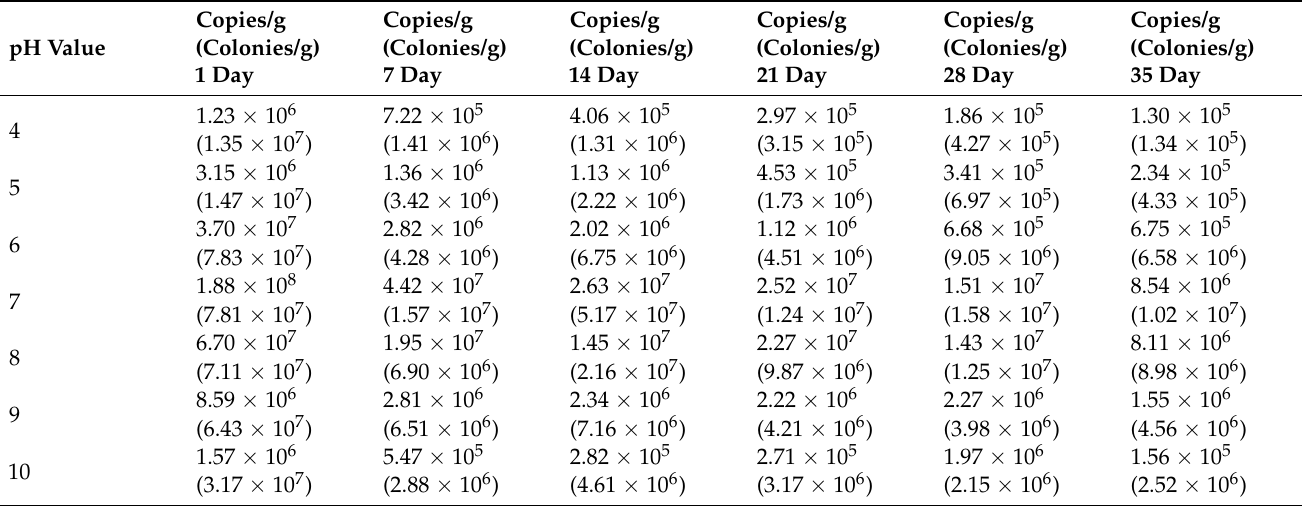
Table 5. The colonization abilities of strain ZF2 in different